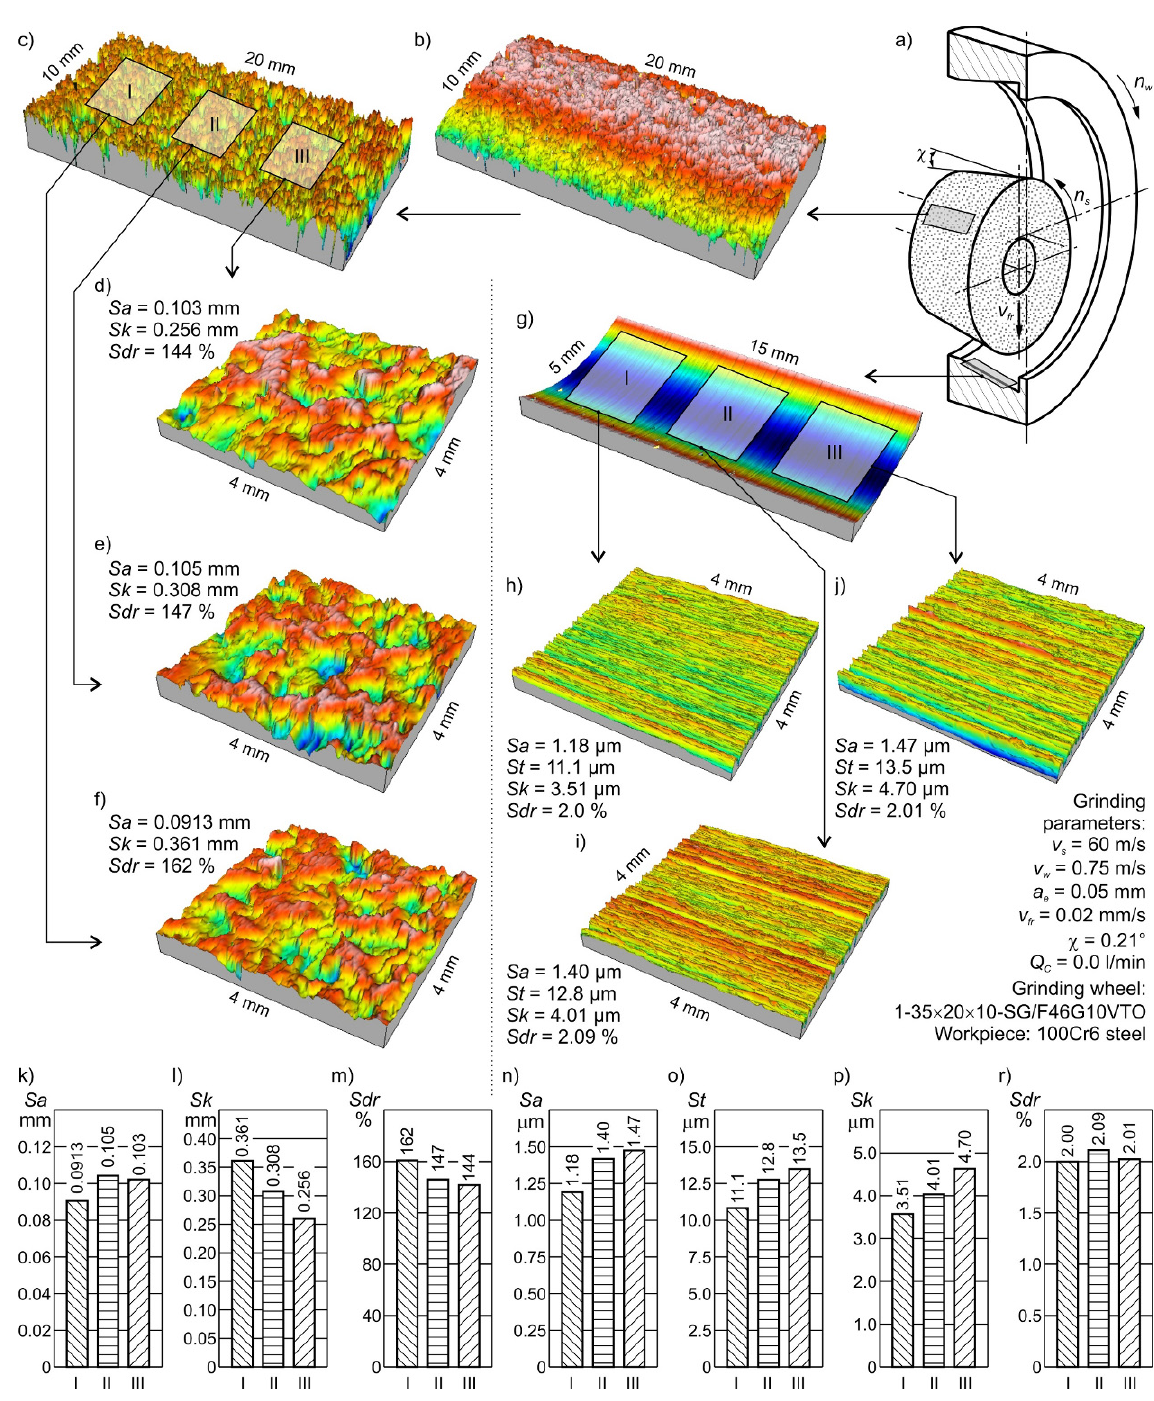
Figure 4. Microtopographies and selected GSS parameters of the active surface of the conical grinding wheel and the workpiece: a) scheme of the process; b) measured microtopography of the GWAS; c) levelled microtopography of the GWAS; d–f) selected GSS parameters for the three zones of the GWAS; g) measured microtopography of the workpiece surface; h–j) selected GSS parameters for the three zones of the workpiece surface; k–m) setting-up of values of the selected GSS parameters for the three areas of the GWAS; n–r) setting-up of values of the selected GSS parameters for the three areas of the workpiece